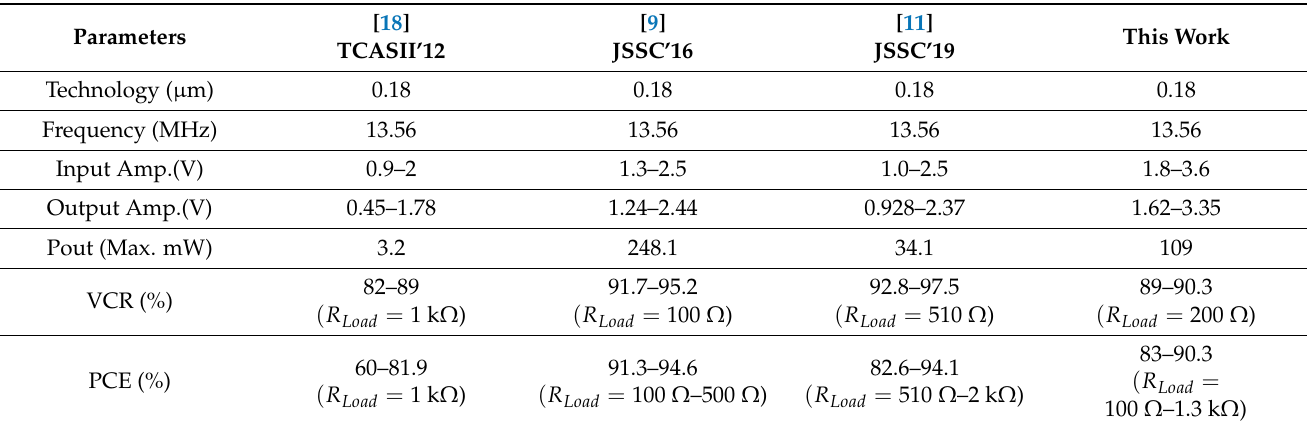
Figure 16. Output current versus different output loads. Table 2. Comparison with prior